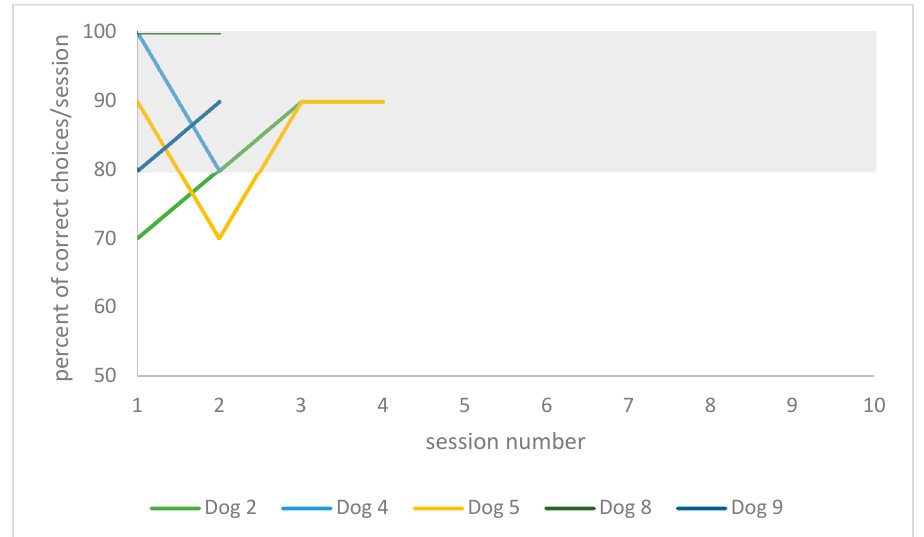
Figure 4. Individual training curves of dogs assigned to the playful activities group. The grey rectangle highlights the successful training criteria area ( ≥ 80% in two consecutive sessions).